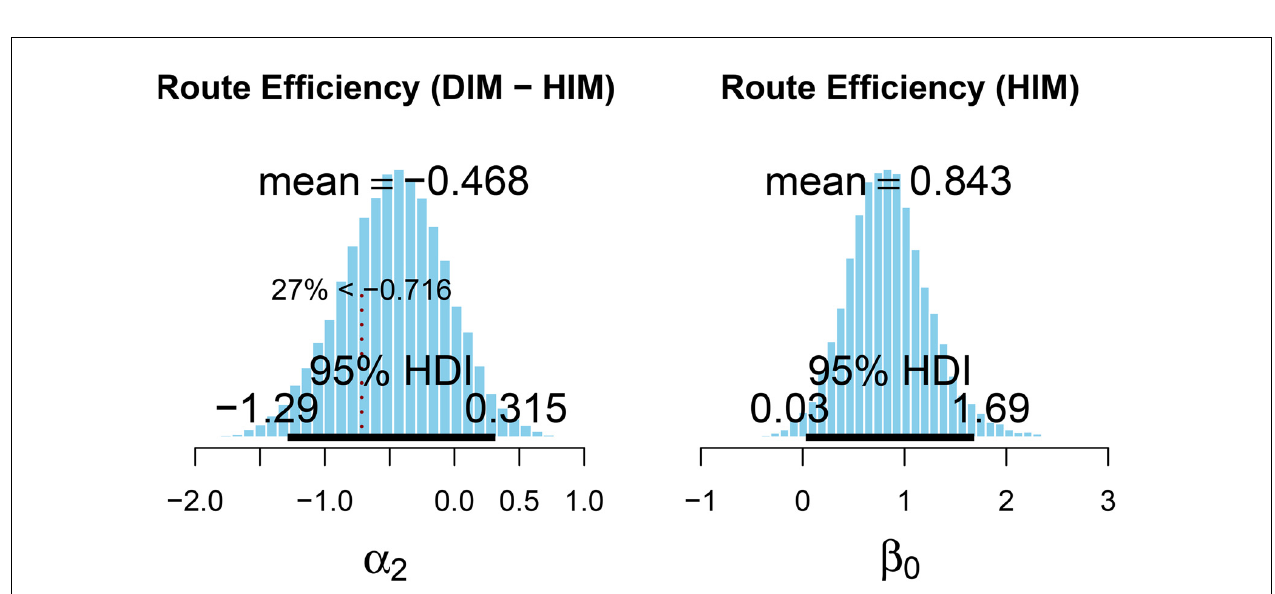
FIGURE 7 | Posterior distribution for the fixed effect (left) and intercept (right) of the test model for route efficiency. The lower region of the ROPE is indicated by the dashed vertical line and corresponds to a value of − 25% route efficiency (based on the mean of the posterior for β 0 ) when using the DIM compared to the HIM. This figure was created using the code provided in DBDA2E-utilities.R (Kruschke, 2014).